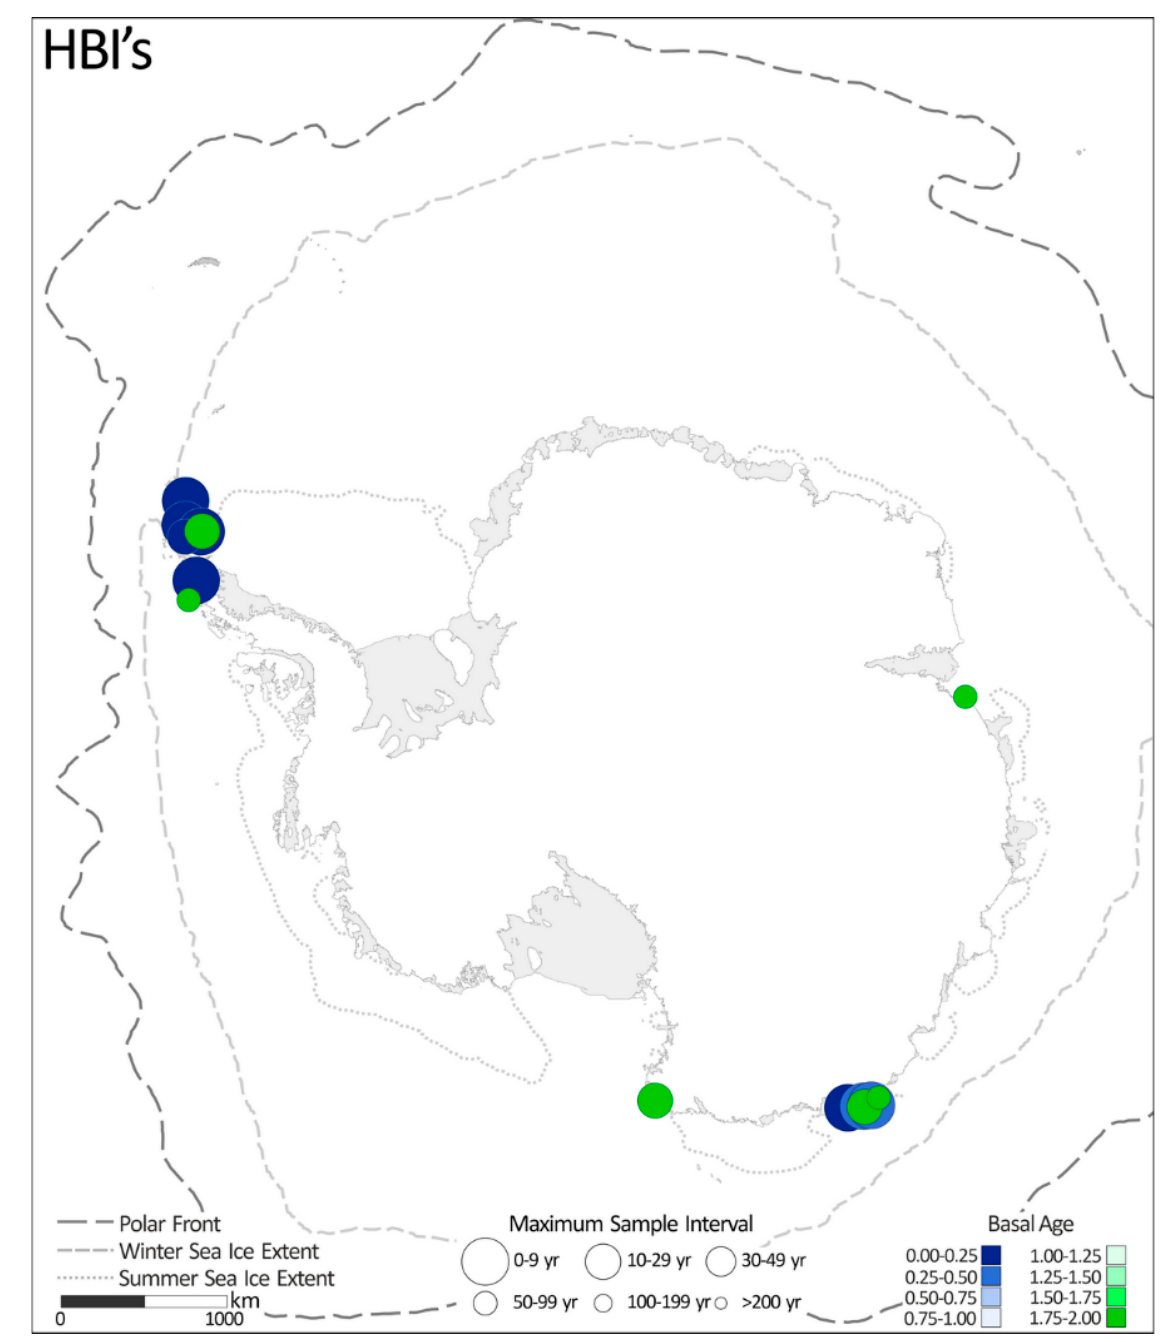
Figure 9. Map showing cores sites where highly branched isoprenoids (HBIs) are used to reconstruct sea ice conditions. The symbol size reflects the resolution of the record and the color of the symbol indicates the basal age of the record between 0 and 2 ka BP.